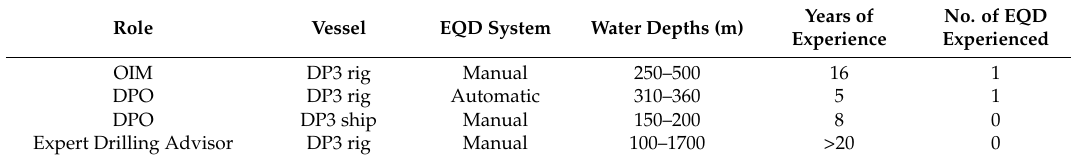
Table 4. Profiles of interviewees.